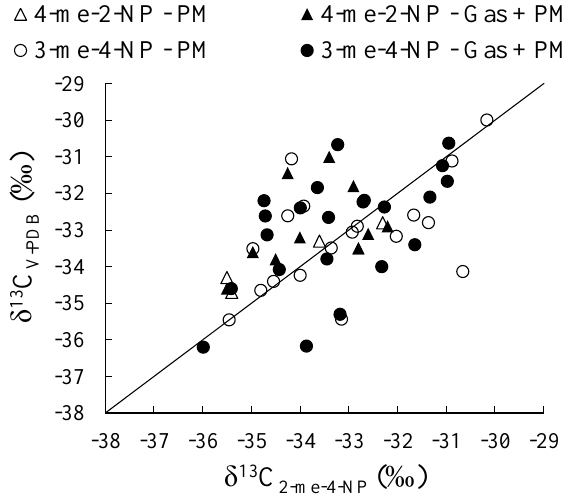
Figure 7. Plot of isotope ratios for 4-methyl-2-nitrophenol and 3- methyl-4-nitrophenol ( y axis) against 2-methyl-4-nitrophenol iso- tope ratios for filter